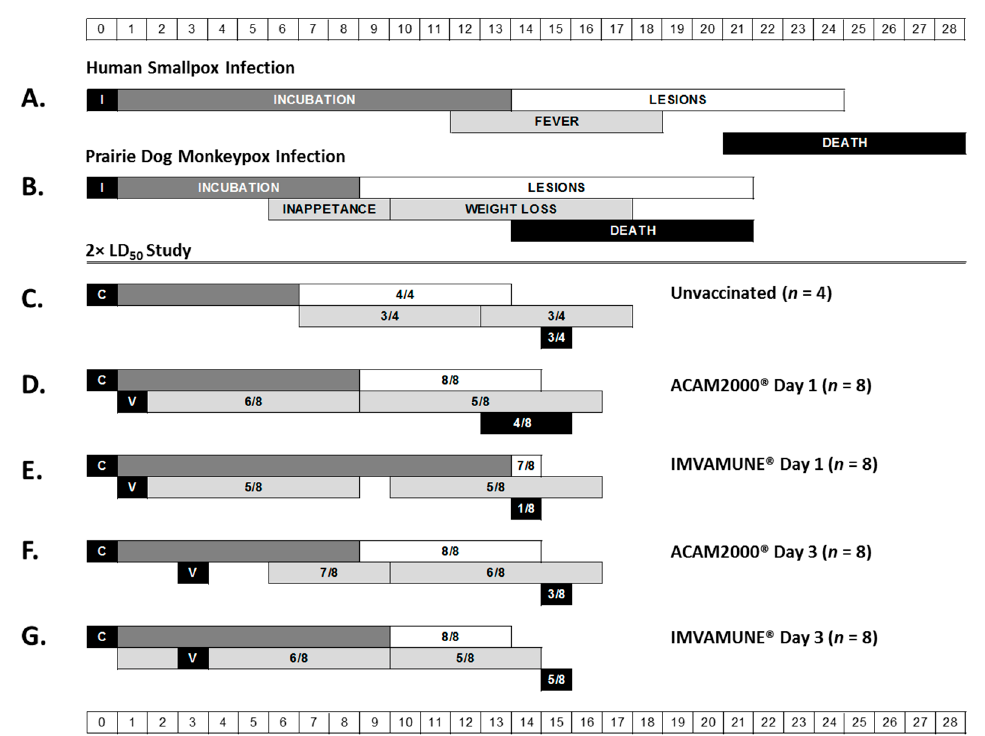
Figure 1. Clinical disease progression. This schematic presents a comparison of the timing of major stages of disease progression in natural human smallpox infection ( A ) and natural prairie dog monkeypox infection ( B ). The major disease stages captured include infection (I) or challenge (C), incubation (dark gray bar), febrile prodrome (light gray bars), rash (white bar), and endpoint (black bar). For human smallpox infection, the prodromal symptom represented is fever. For prairie dog monkeypox infection, the prodromal-like symptoms represented are inappetence (left light gray bar) and weight loss (right light gray bar). Endpoint represents either resolution of lesions / survival or death. The remaining rows show the results of the 2 × LD 50 study for unvaccinated animals ( C ), animals vaccinated (V) on Day 1 with ACAM2000 ® ( D ) or IMVAMUNE ® ( E ), or animals vaccinated on Day 3 with ACAM2000 ® ( F ) or IMVAMUNE ® ( G ). For study data, the bars (color coded as described above) represent the range of days postexposure when the onset of each stage was observed in each individual animal. The fractions in the boxes represent the number of study animals that manifested clinical signs of each stage over the total number of animals in that group.